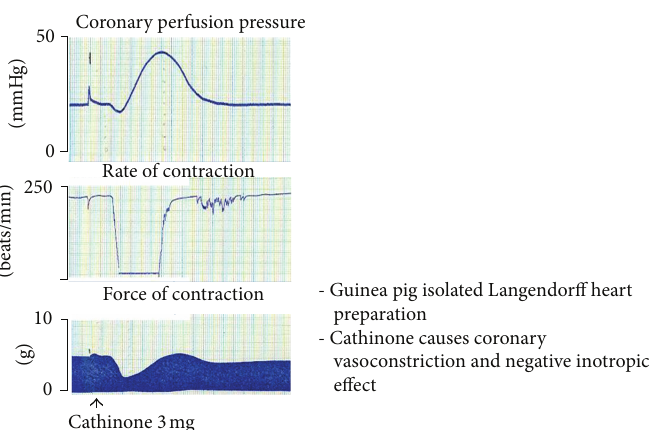
Figure 2: The vascular effect of cathinone in pigs; a courtesy from Dr. Ahmed